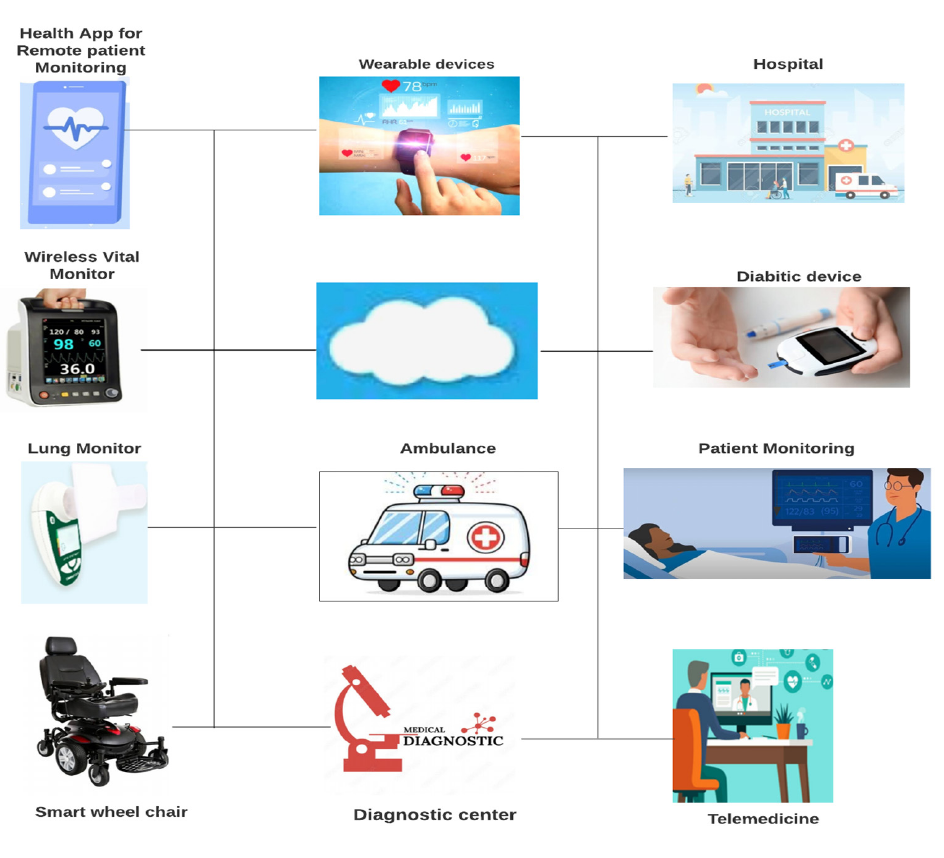
Figure 3. Applications of IoMT.